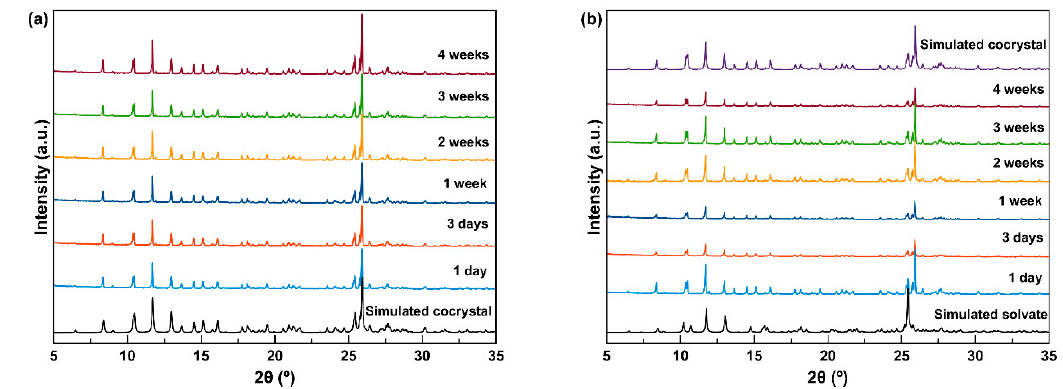
Figure 12. PXRD patterns of HCT–CAF ( a ) and HCT–CAF·MET ( b ) with respect to the stability under accelerated ageing conditions (40 °C, 75% RH) at different time intervals.